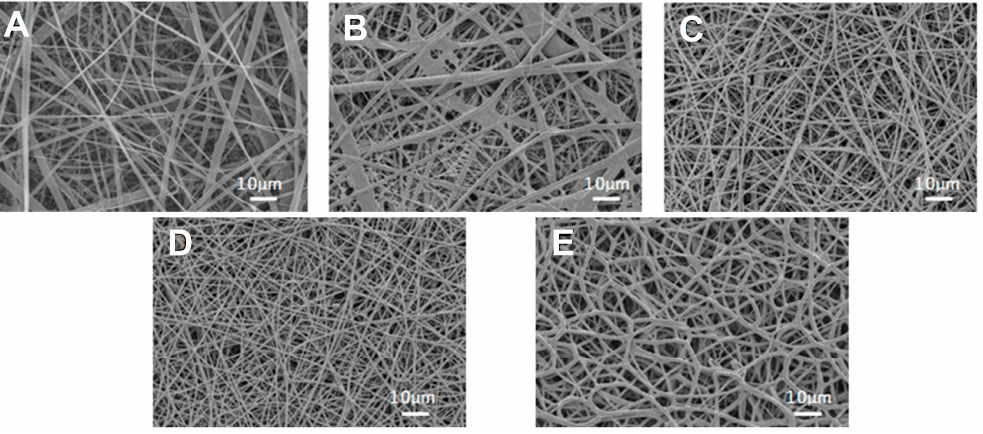
Figure 2. SEM image of SF/PU = ( A ) 10/0; ( B ) 7/3; ( C ) 5/5; ( D ) 3/7; and ( E ) 0/10 composite non-woven Figure 2. SEM imageof SF/PU= ( A ) 10/0; ( B ) 7/3; ( C ) 5/5; ( D ) 3/7; and( E ) 0/10composite non-wovensheet. sheet. Table 1. Fiber diameters of SF/PU composite non-woven Table 1. Fiber diameters of SF/PU composite non-woven sheets.